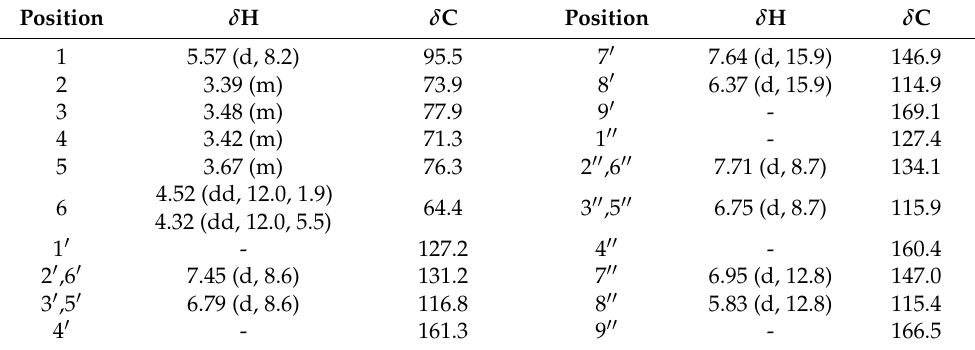
Figure 7. The structures of phenylpropanoids ( 29 – 37 ) isolated from Diaphragma juglandis Fructus. Table 3. 1 H-NMR (600 MHz) and 13 C-NMR (150 MHz) of 29 in methanol- d 4 ( δ in ppm, J values in